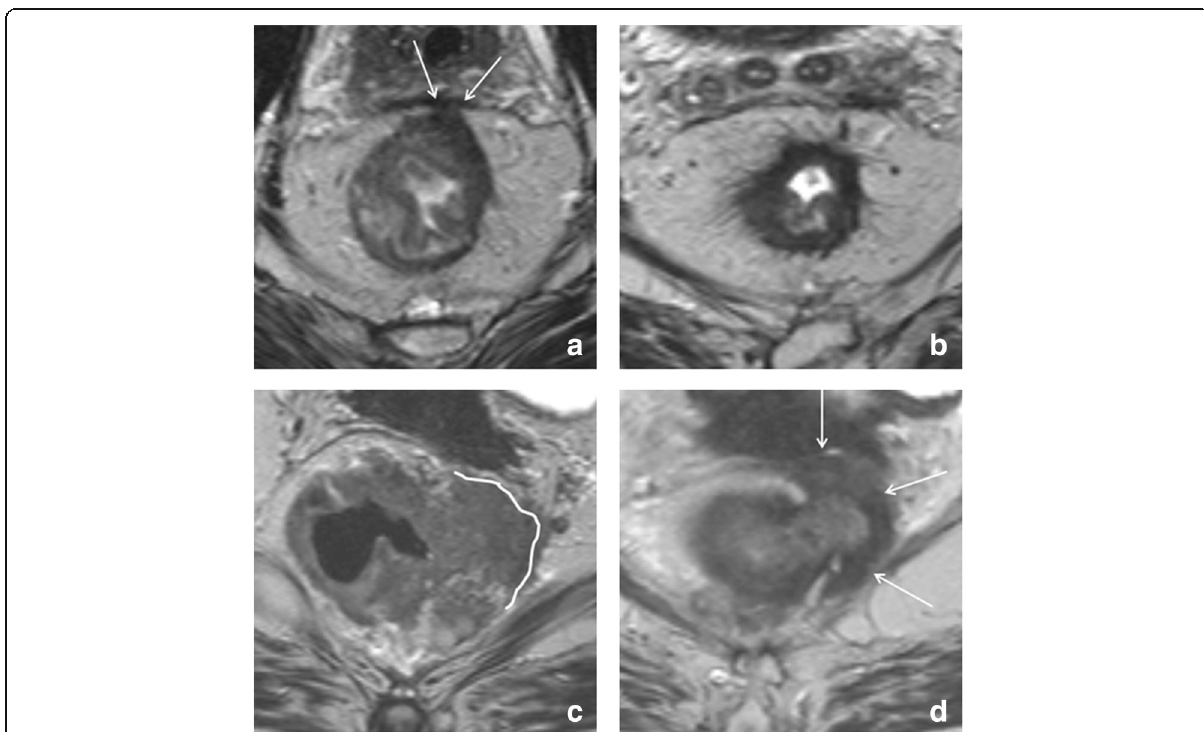
Fig. 4 Patterns to predict mesorectal fascia involvement after CRT. Example of two morphologic patterns that can aid in predicting MRF involvement after CRT. The male patient in the upper row has a mid-rectal tumor that invades the MRF anteriorly (arrows in a ). After CRT ( b ), the tumor has retracted from the MRF, only some slight fibrotic stranding towards the MRF remains. Subtle fibrotic stranding (or a cleared fat plane) are signs indicating a high chance of a tumor-free MRF, which was indeed confirmed at histopathology after surgery in this patient. The female patient in the bottom row has a mid-rectal tumor with extensive MRF invasion at the left lateral side (white line in c ). After CRT ( d ), the tumor has decreased in volume, but there is still an isointense mass surrounded by hypointense fibrosis that involves the MRF from 1 to 4 o ’ clock (arrows in d ). This type of diffuse MRF infiltration reliably predicts persistent MRF involvement, which was indeed confirmed at histopathology after surgery in this patient